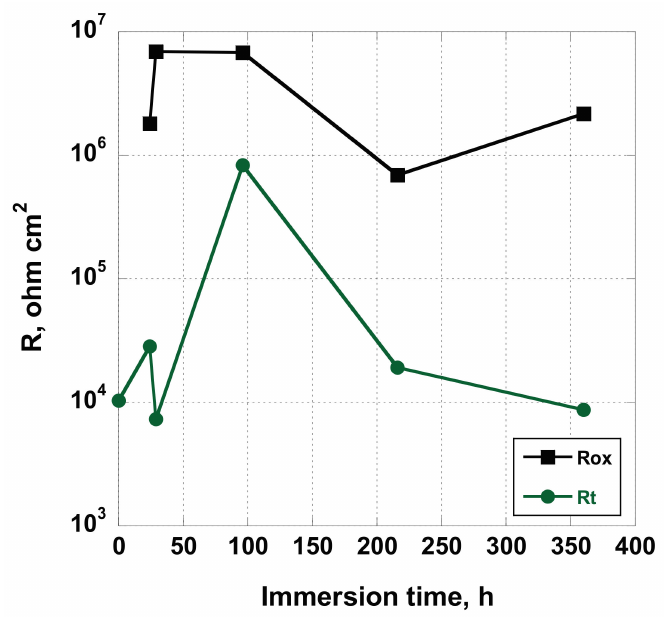
Figure 16. Variation of R ox and R t as a function of time of immersion in Hank’s solution displayed by the NT